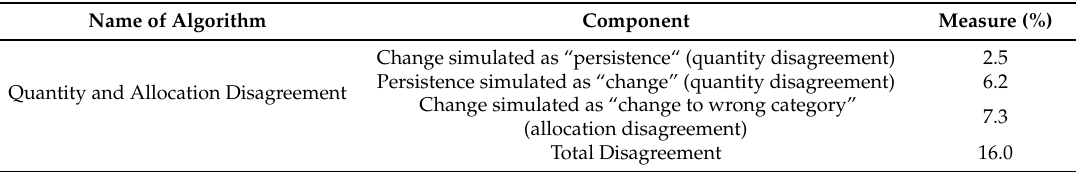
Table 7. Map comparison indices for the simulated and observed land-cover of